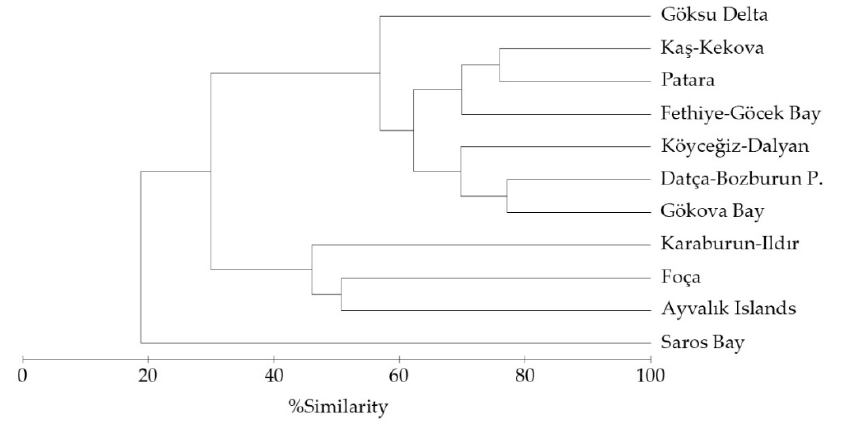
Figure 2. Group average sorting dendrogram of Turkish MPAs based on binary data (presence and absence) of alien taxa. Table 2. Percentage distribution of alien species phyla in Turkish MPAs. Phyla Saros Ayvalık Foça